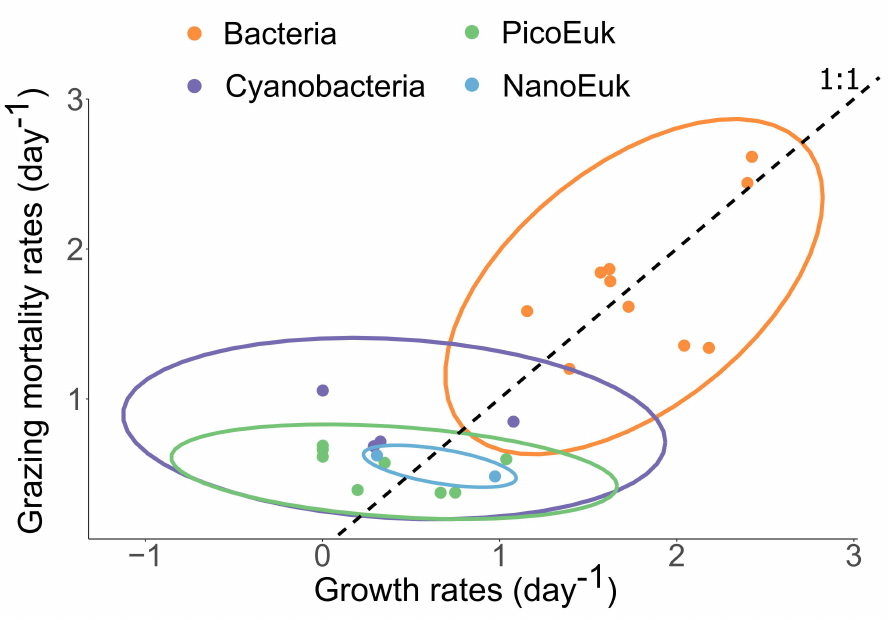
Figure 6. Representation of the g: µ ratios as grazing mortality rates relative to growth rates (day − 1 ) of the studied MFW components, including bacteria (orange), cyanobacteria (purple), PicoEuk (green), and NanoEuk (blue) for eukaryotic pico- and nanophytoplankton groups. The ellipses highlight the trend of the g:µ ratio for each type of microorganism. Black, dashed line represents the 1:1 ratio and allows quick vision of positive (accumulation of cells) or negative (decreasing of cell abundance) ratios of the planktonic groups.